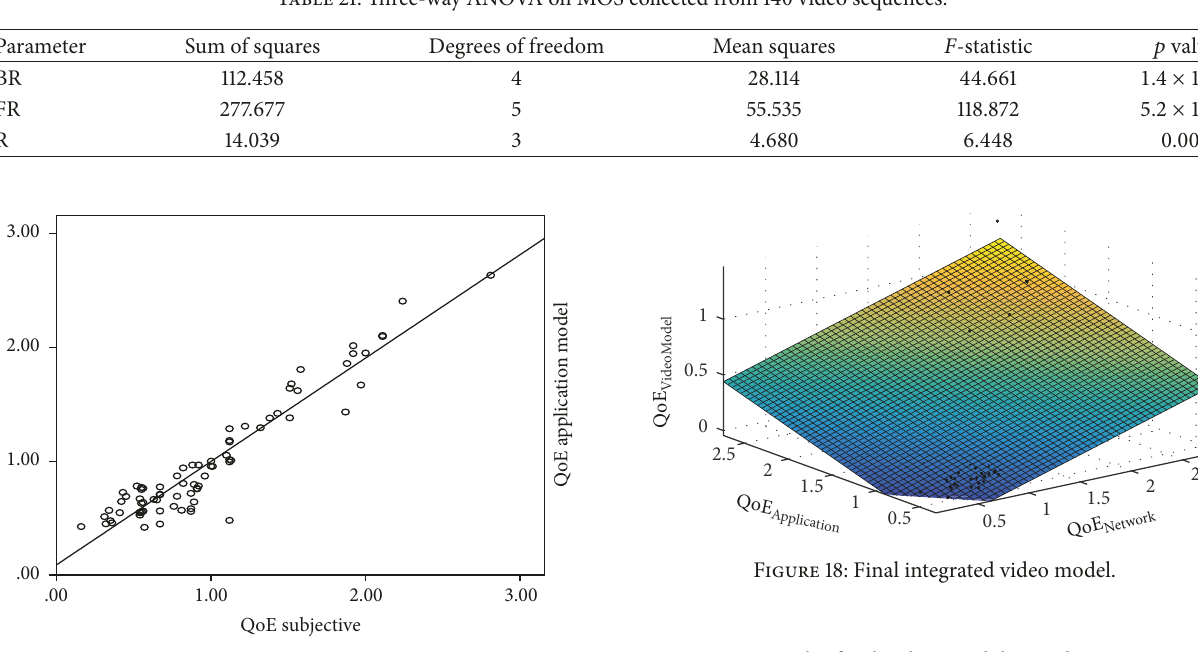
Table 21: Three-way ANOVA on MOS collected from 140 video sequences.